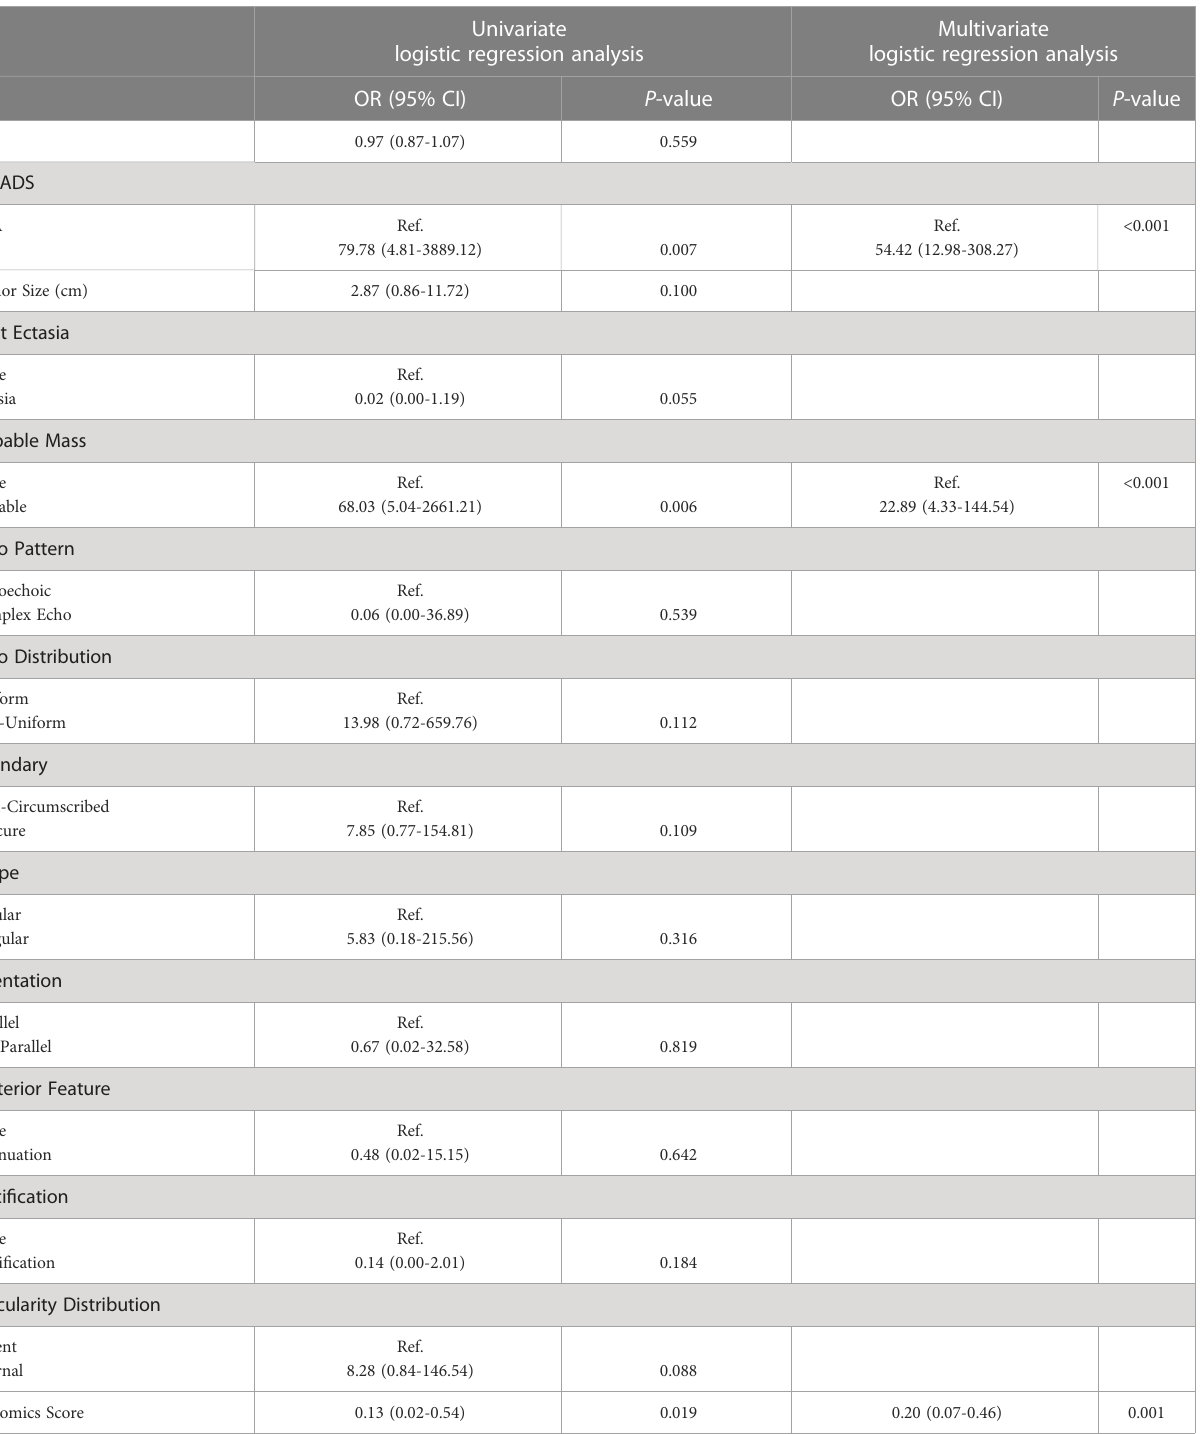
TABLE 2 Results of the univariate and multivariate logistic regression analysis in the training cohort.